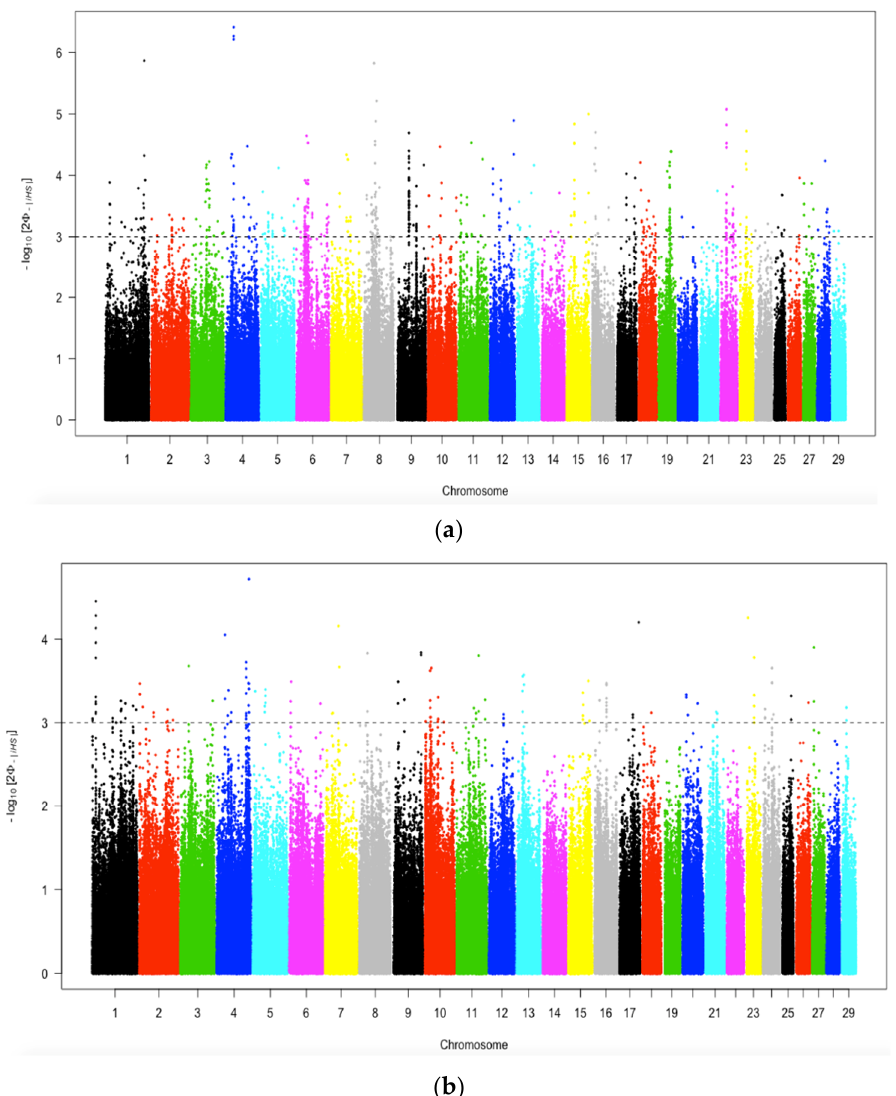
Figure 8. Genome−wide distribution of selection signatures detected by iHS on 29 autosomes in the Bartlow Combine ( a ) and Kokstad ( b ) Nguni cattle populations. The dotted horizontal line shows the cut-off |iHS| value to call SNP outliers.